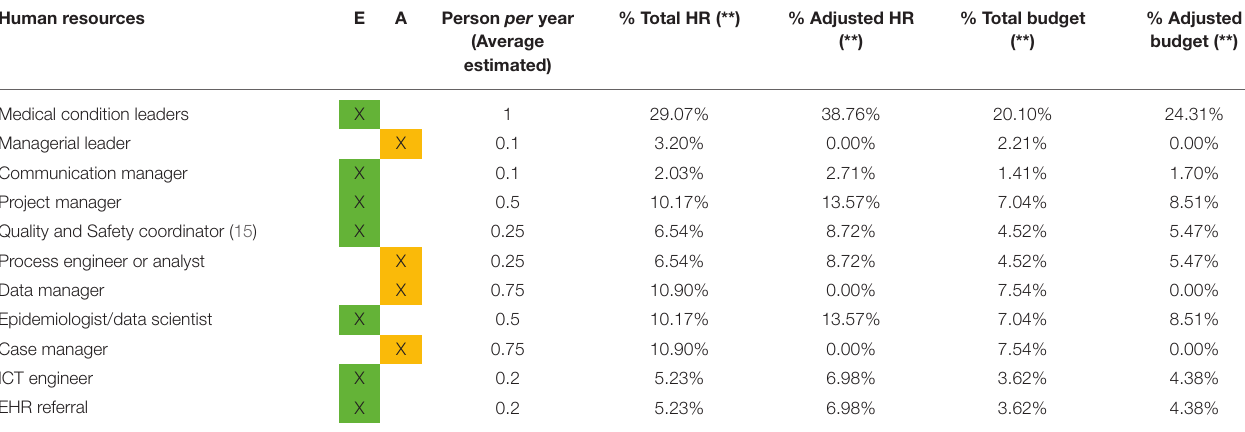
TABLE 1 | Budget impact of each professional role key for implementation. Human